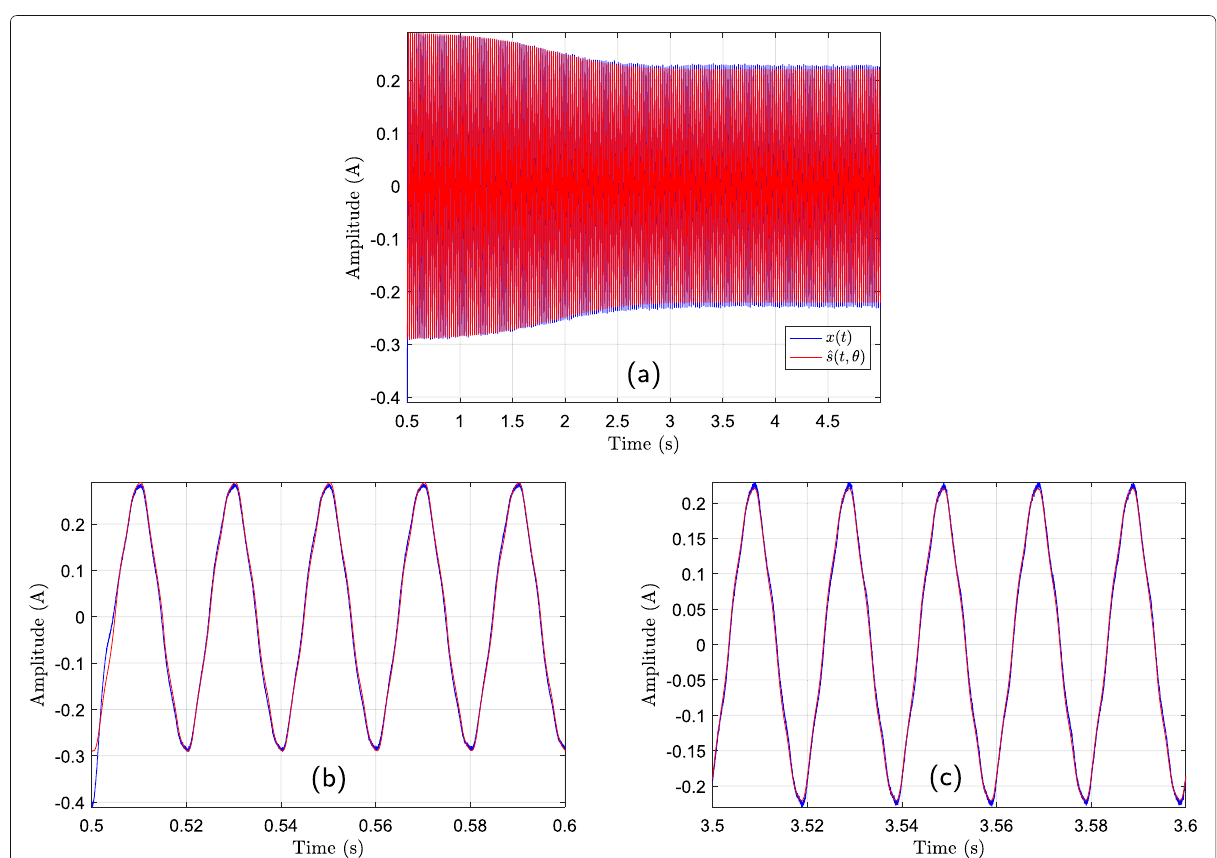
Fig. 14 Turn-on transient current of a fan from the COOLL dataset (in blue) with the reconstructed signal (in red) generated using the estimated parameters with the TCE algorithm. a Current signals, b zoom on the interval [0.50 − 0.60] s, and c zoom on the interval [3.50 − 3.60] s